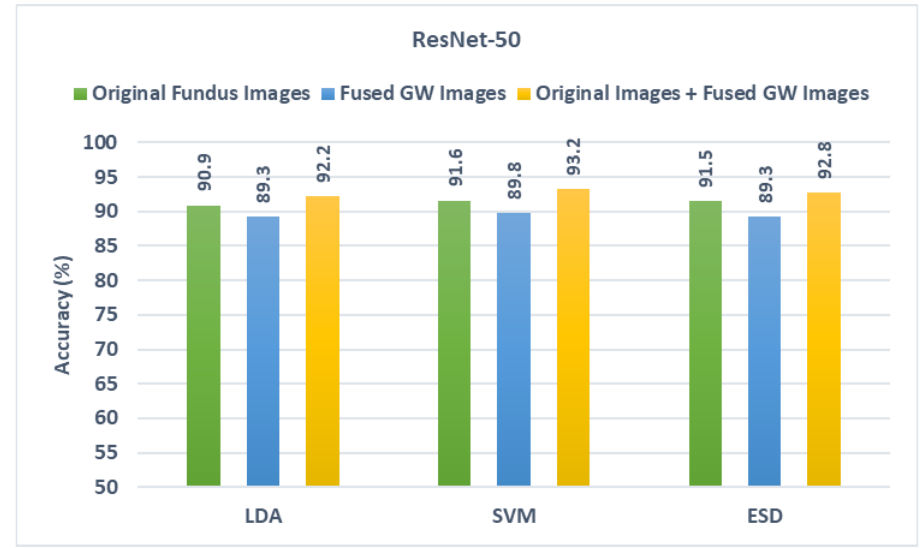
Figure 7. Diagnostic accuracy of the three classifiers trained with spatial features extracted from ResNet-50 learned using the original fundus images compared the fused DWT features obtained by CNNs learned with GW images and the combination of the two.